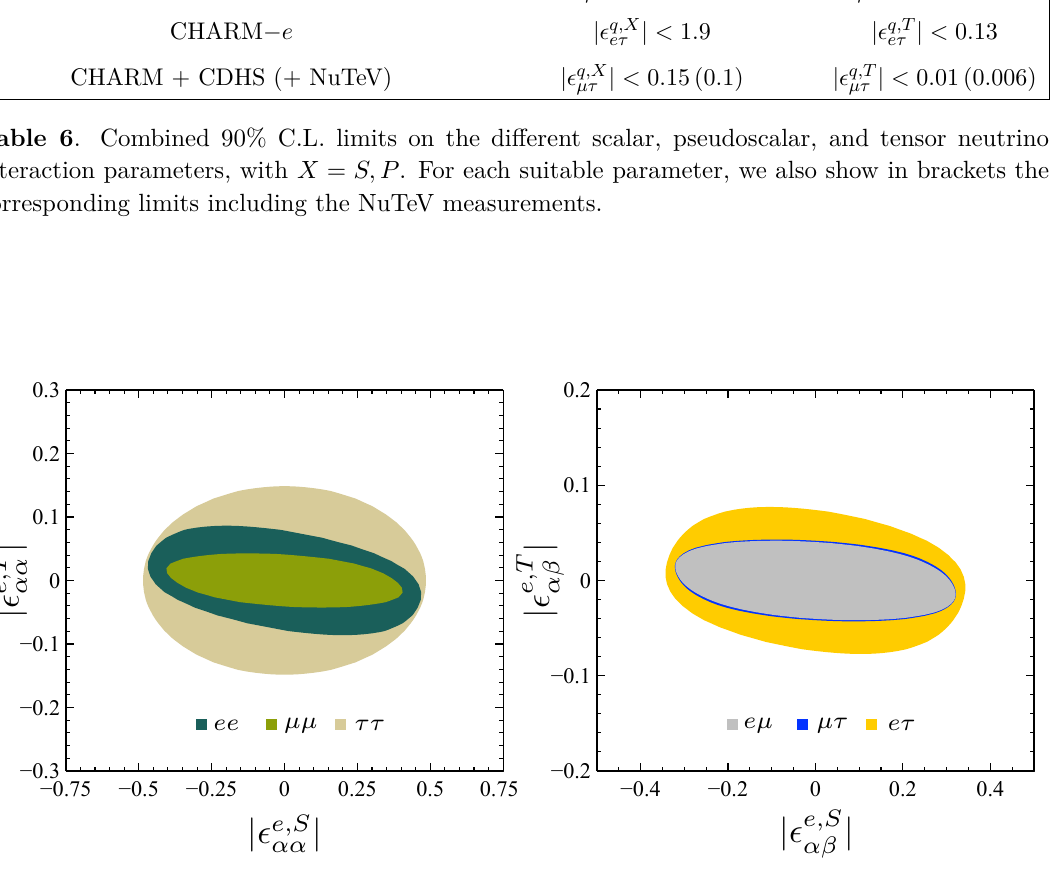
Figure 4 . Global constraints on the scalar and tensor neutrino-electron parameters, at 90% C.L. The same combination of experiments as in table 6 was used. The left (right) panel shows the constraints on the diagonal (nondiagonal)